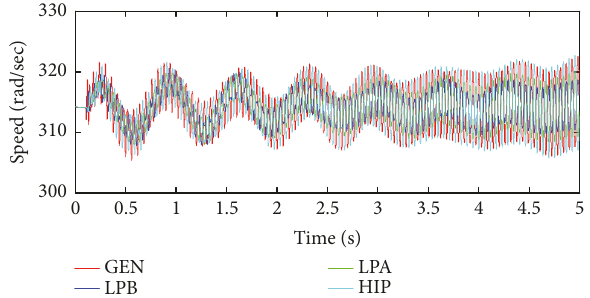
Figure 9: The torsional torque in GEN-LPB shaft sections of Vungang I and II plant’s unit 1 during and after clearing fault.